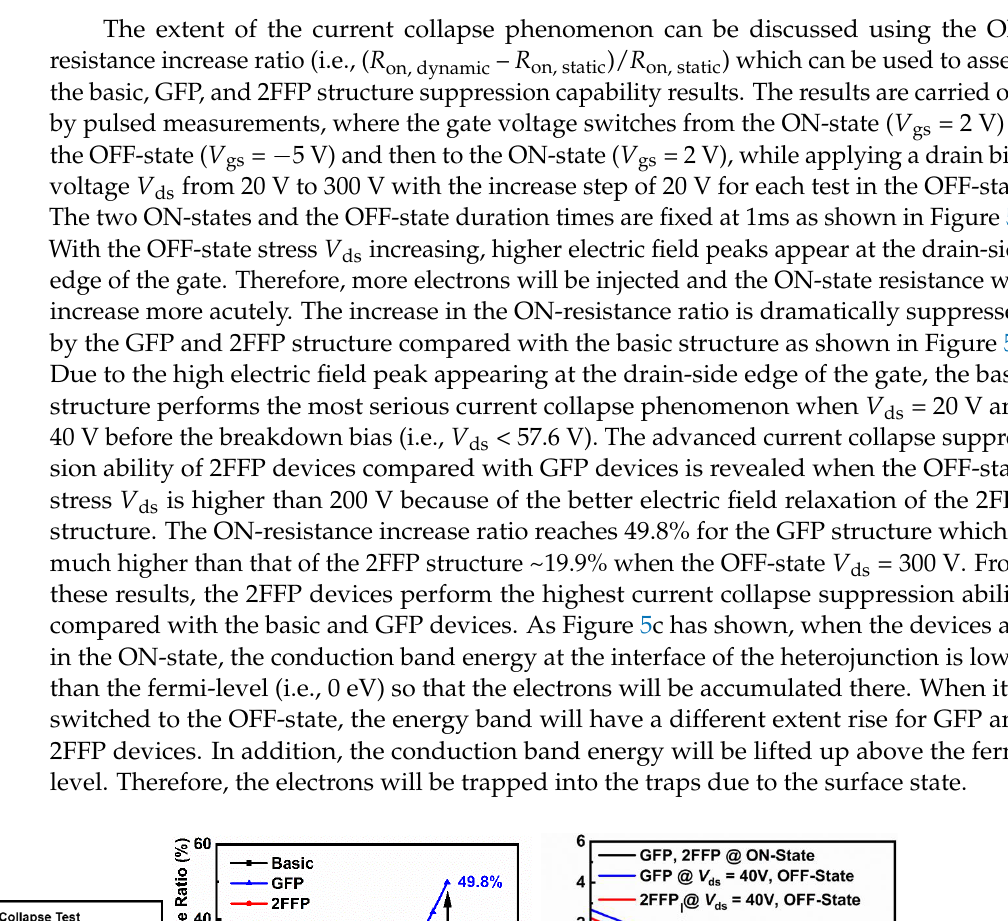
( c ) Figure 6. ( a ) Parasitic capacitances ’ varying curves of the basic, GFP, and 2FFP structures and the cut-off frequency and maximum oscillation frequency of ( b ) GFP HEMT and ( c ) 2FFP HEMT. The typical small signal characteristics for the GFP and 2FFP structure devices can be seen in Figure 6b,c. The cut-off frequency f t value is extracted from the extrapolation of the |H 21 | 2 parameter, where its slope equals − 20 dB/dec and reaches the gain of 0 dB. The